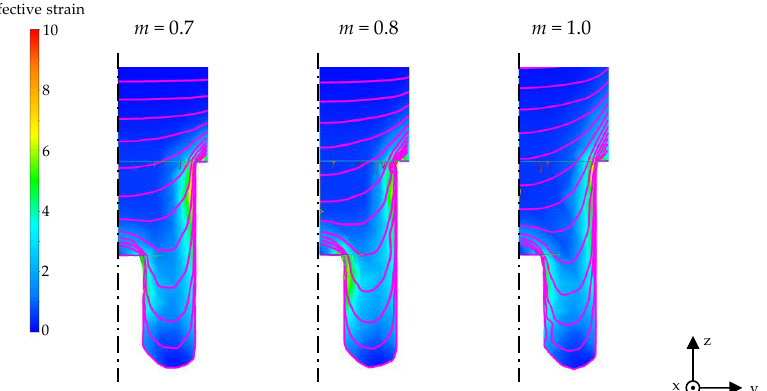
Figure 7. Material flow highlighted in the container and the upper part of the tool for different friction values.